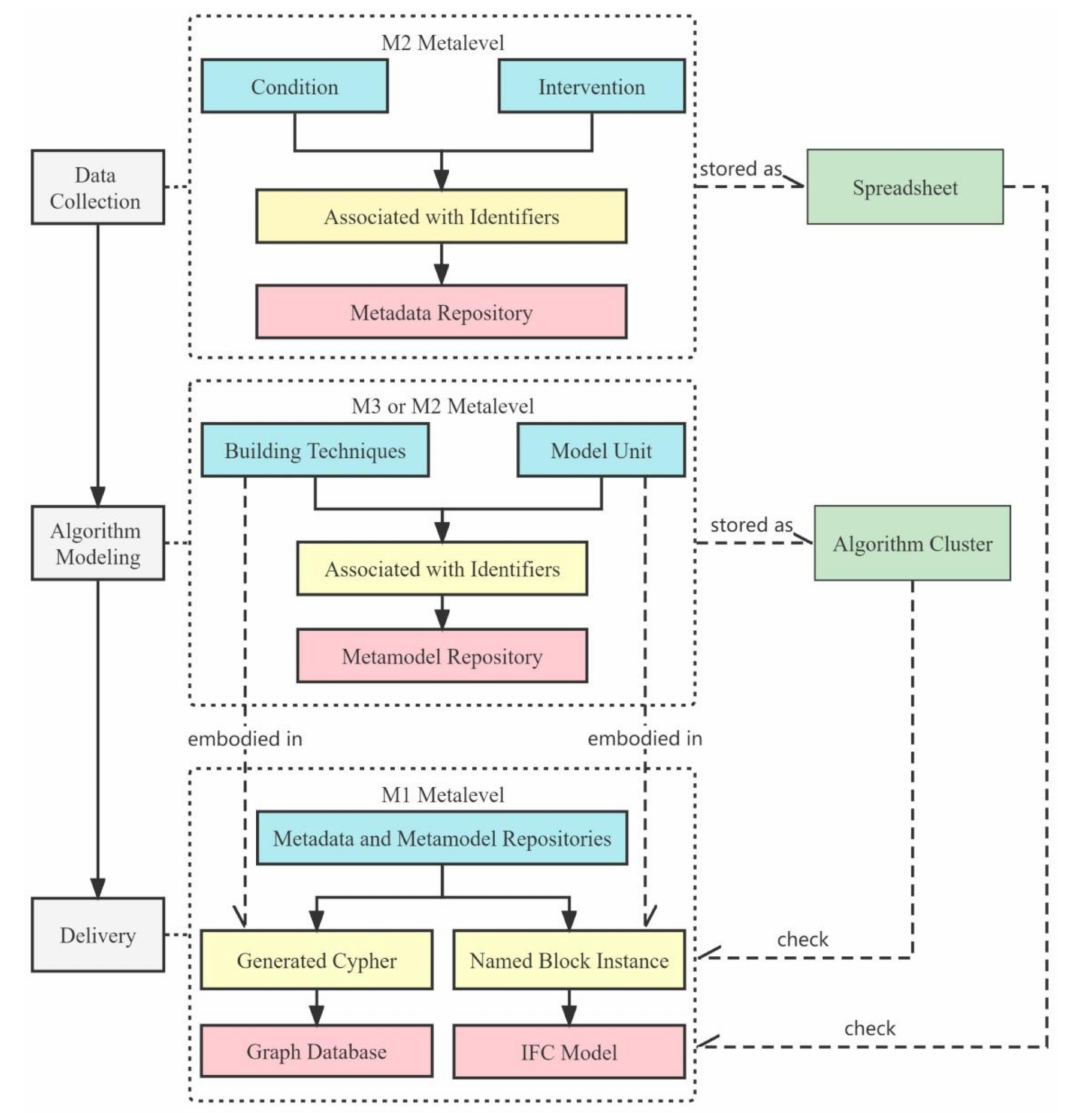
Figure 1. Structure of the proposed